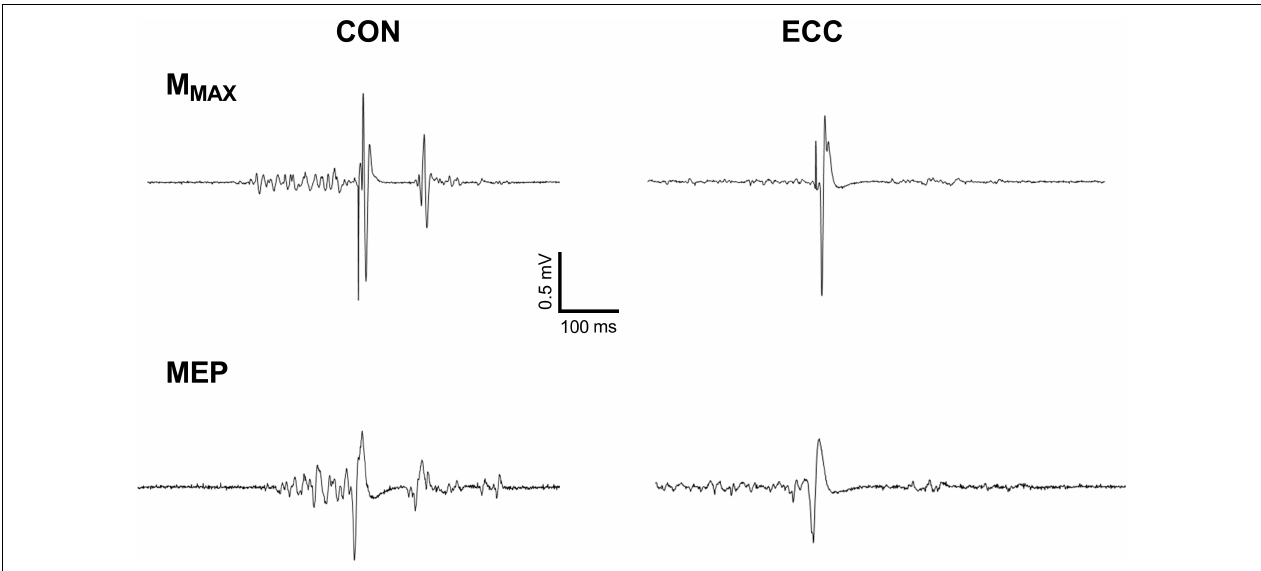
FIGURE 3 | Raw traces of the response to femoral nerve and transcranial stimulations for the vastus lateralis muscle. The figure shows motor-evoked potential (MEP) and maximal M-waves (M MAX ) during concentric (CON) and eccentric (ECC) cycling of a representative participant.